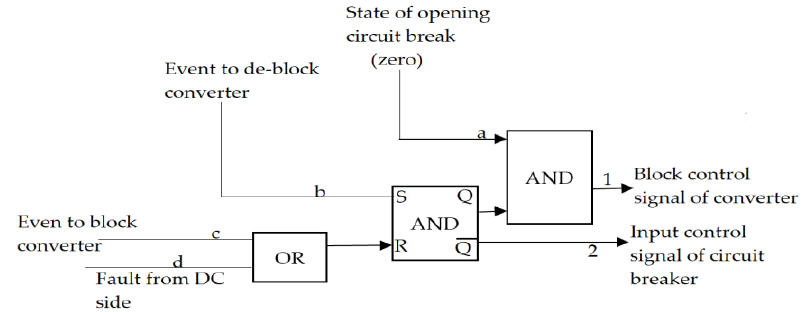
Figure 7. Converter block/de-block module